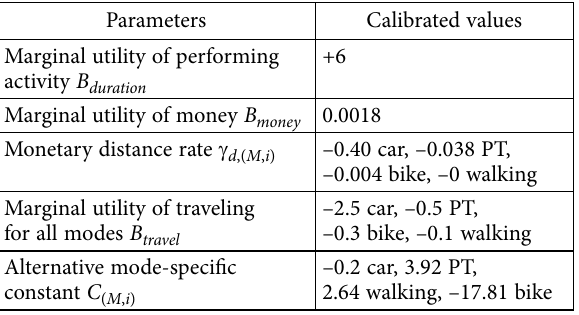
Table 2. Transport mode choice coefficients